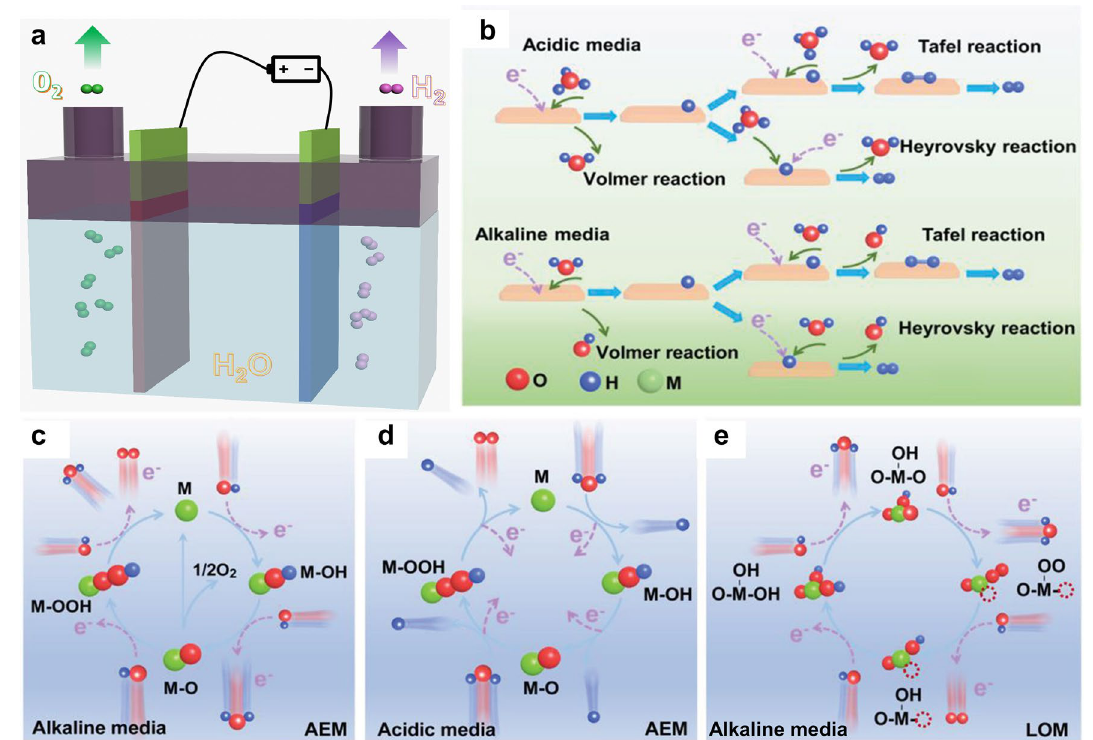
Fig. 1 a Illustration of the water electrolyzer. b HER mechanisms in acidic and alkaline electrolytes. c Adsorbate evolution mechanism (AEM) for alkaline OER. d AEM for acidic OER. e Lattice oxygen participation mechanism (LOM) for alkaline OER, the dotted red circle represents the oxygen vacancy [50]. Copyright 2022,